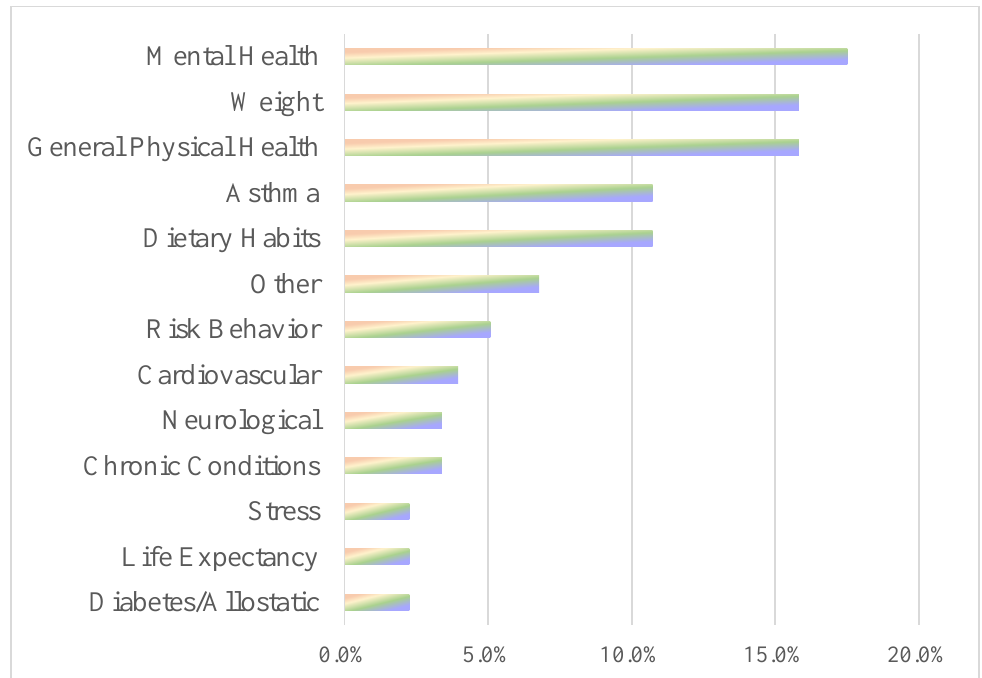
Figure 3. Total percent of articles reporting on health outcomes, measurements, or behaviors.